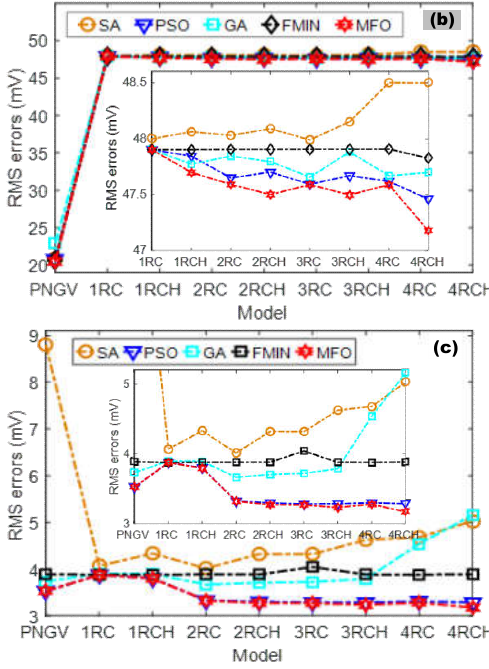
Figure 4. Comparison of identification results. ( a ) In the entire state-of-charge (SOC) area; ( b ) in the low SOC area (0–20%); and ( c ) in the high SOC area (20–100%).